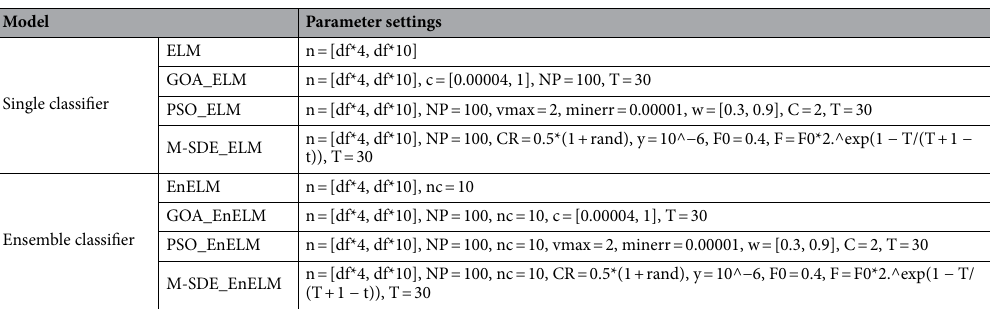
Table 3. Setting of experimental